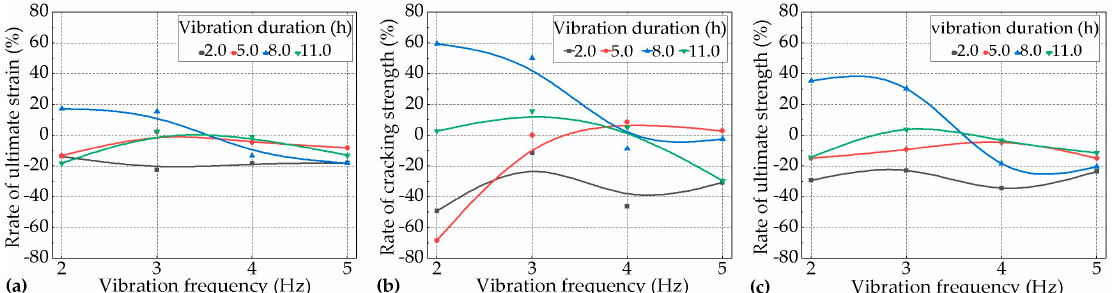
Figure 9. Rates of ( a ) the ultimate tensile strain, ( b ) cracking strength, and ( c ) ultimate tensile strength for the vibrated groups over the control group with the increase of the levels of vibration frequency during the period between the initial set and the final set under di ff erent lengths of durations (Var. 2). 3.4. Grey Correlation Analysis of the Factors A ff ecting the Tensile Performance of the